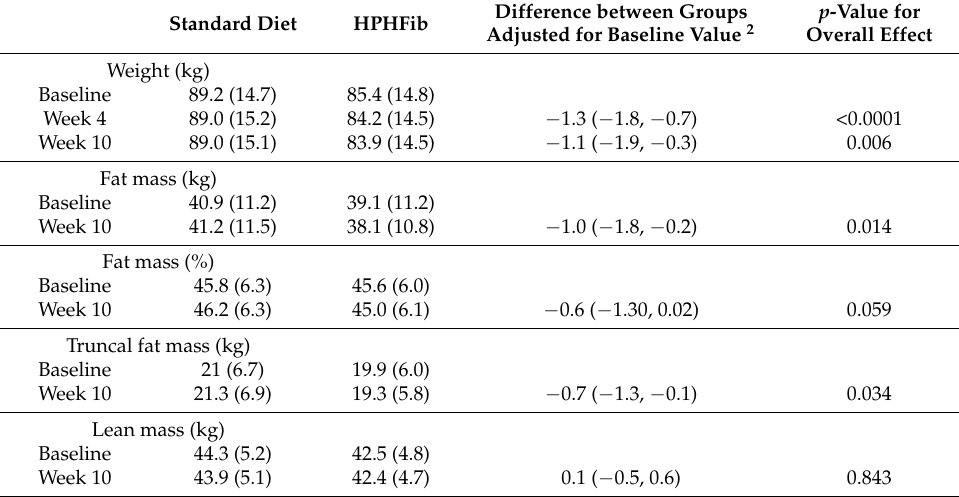
Table 3. Mean (SD) measures of body composition at baseline, week 4 1 and week 10 and adjusted differences between dietary